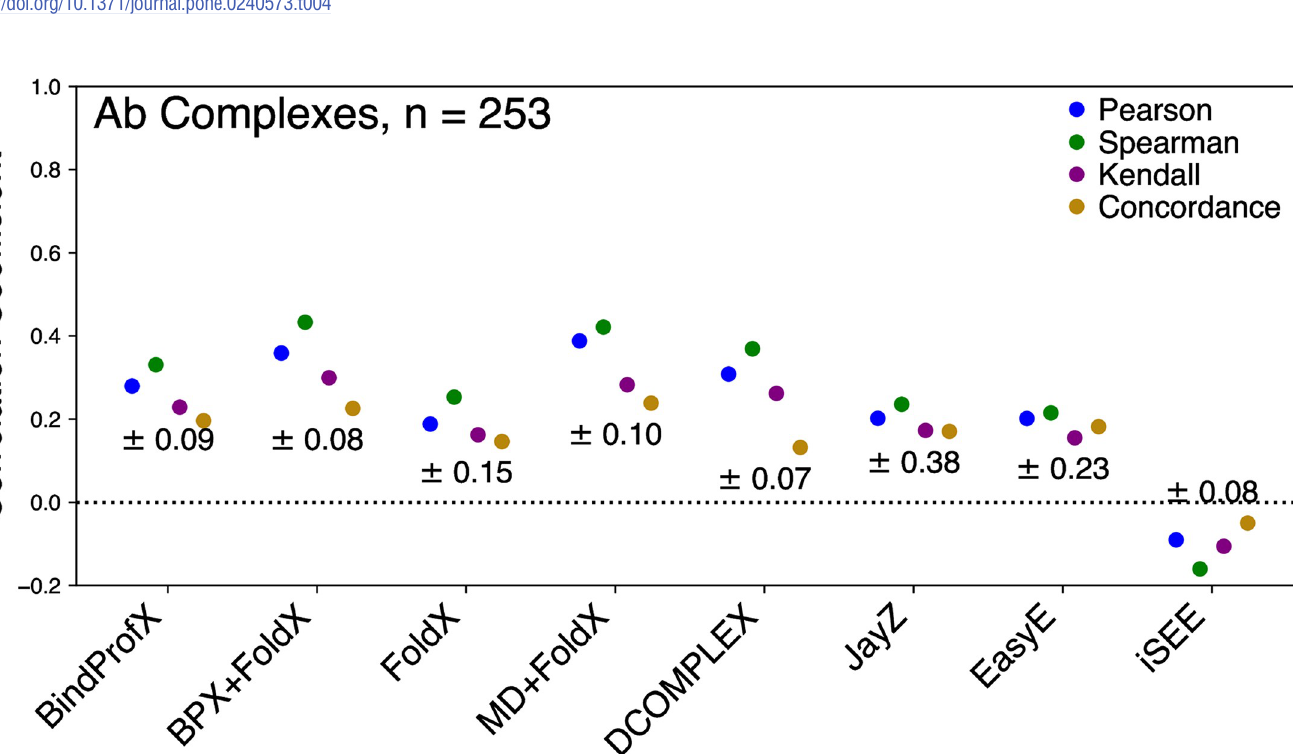
Fig 4. Performance of each evaluated method for Ab complexes (253 total mutations) in predicting true ΔΔ G values ( ρ c ), linearly correlated ΔΔ G values ( r ), and rank order ( ρ and τ ). The error for each method is reported under the correlation points.